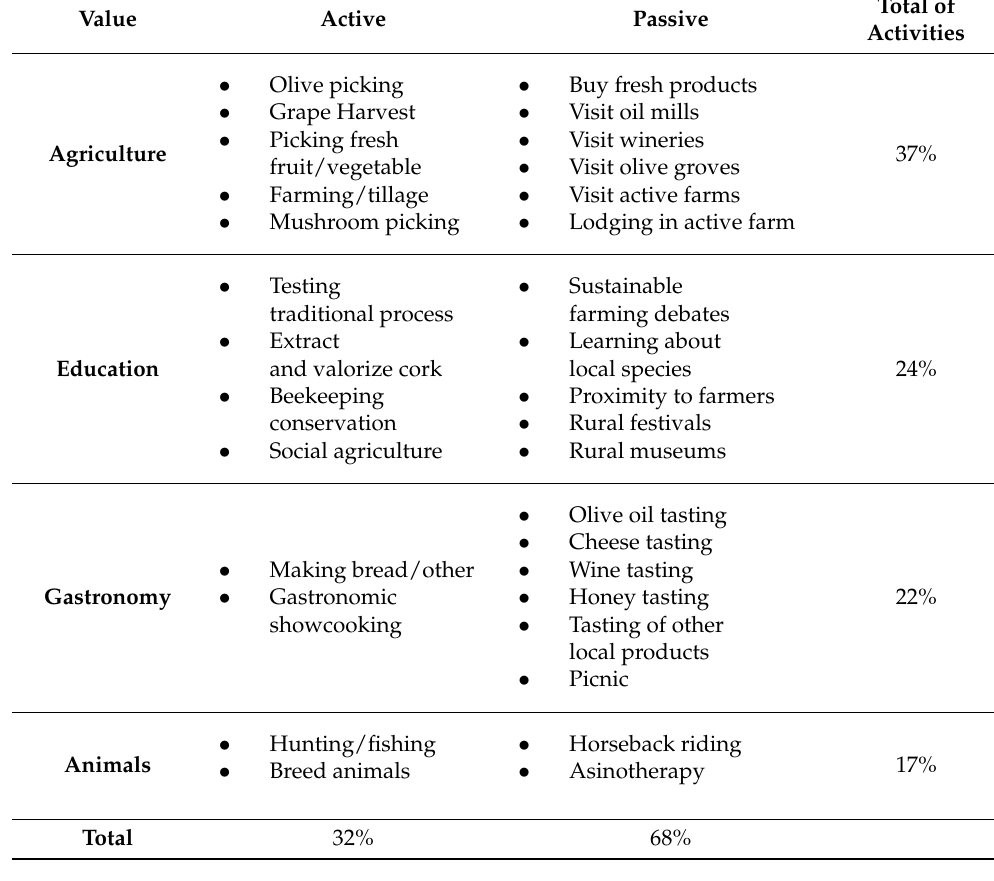
Table 6. Agritourism activities (n =